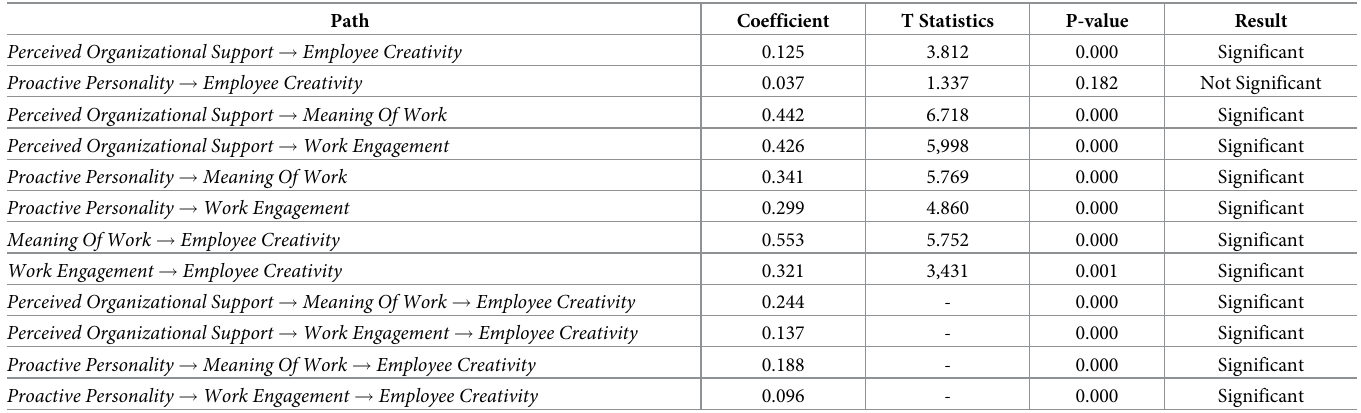
Table 6. Path analysis of direct and indirect effects.